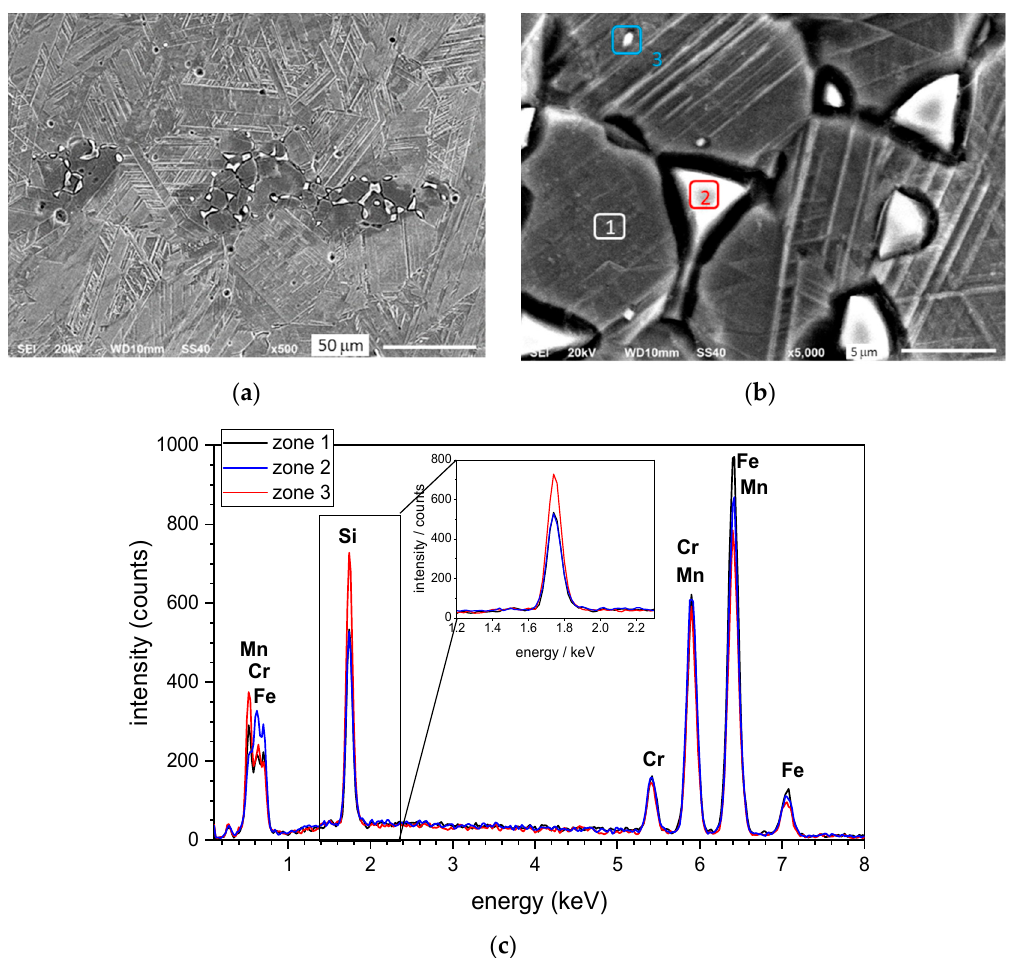
Figure 3. SEM micrograph of the Fe-28Mn-6Si-5Cr SMS alloy after thermal activation ( a ), a detail of the precipitate morphology ( b ), EDS spectra corresponding to zones 1, 2, and 3 indicated in Figure 3b ( c ).